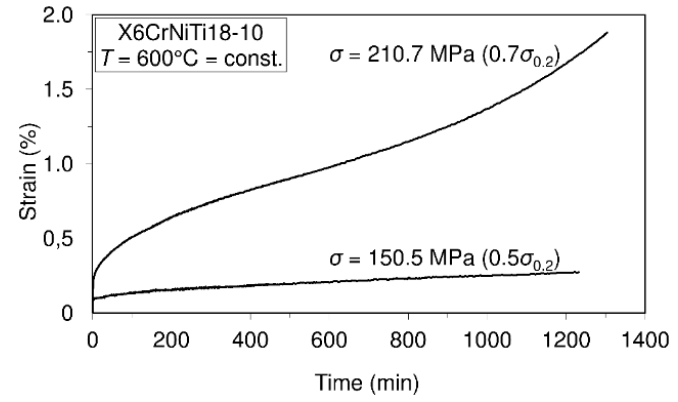
Figure 7. Creep behavior of steel X6CrNiTi18-10 at a temperature of 600 °C.